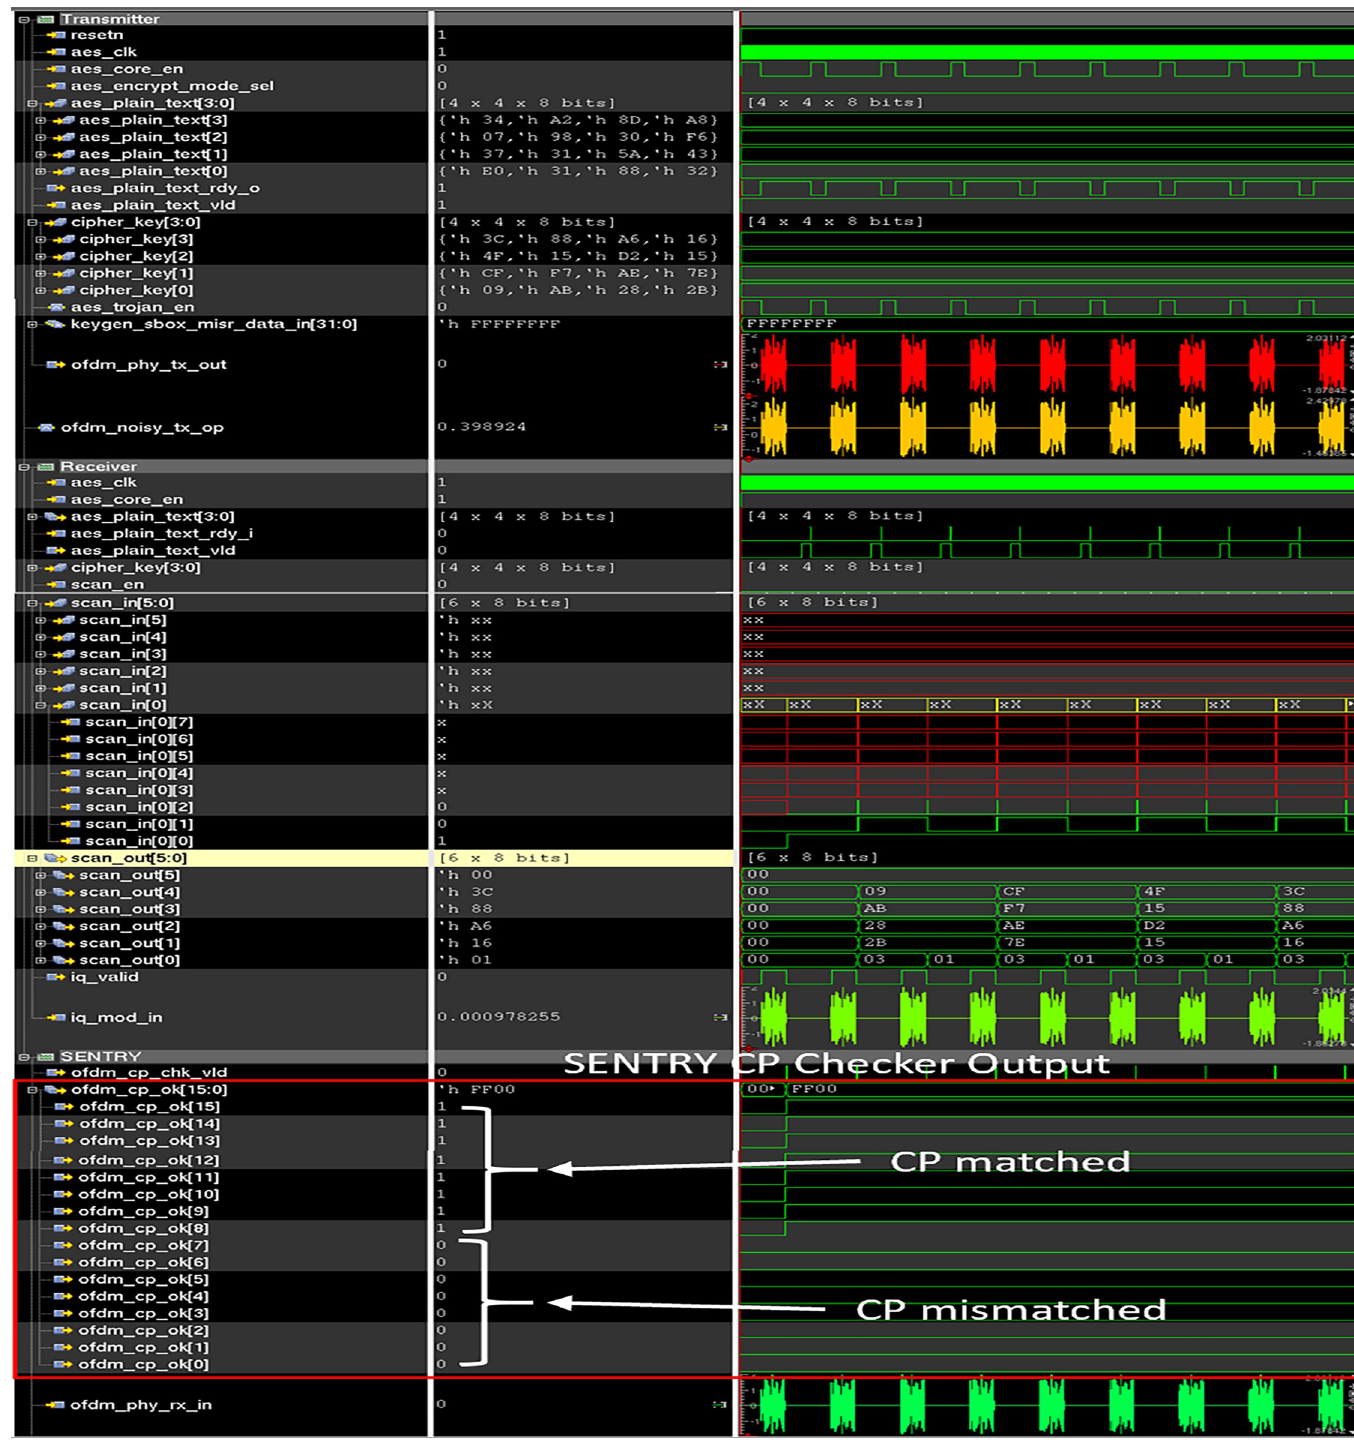
Fig 19. Simulation waveform of SENTRY with trojan infested wireless crypto IC.